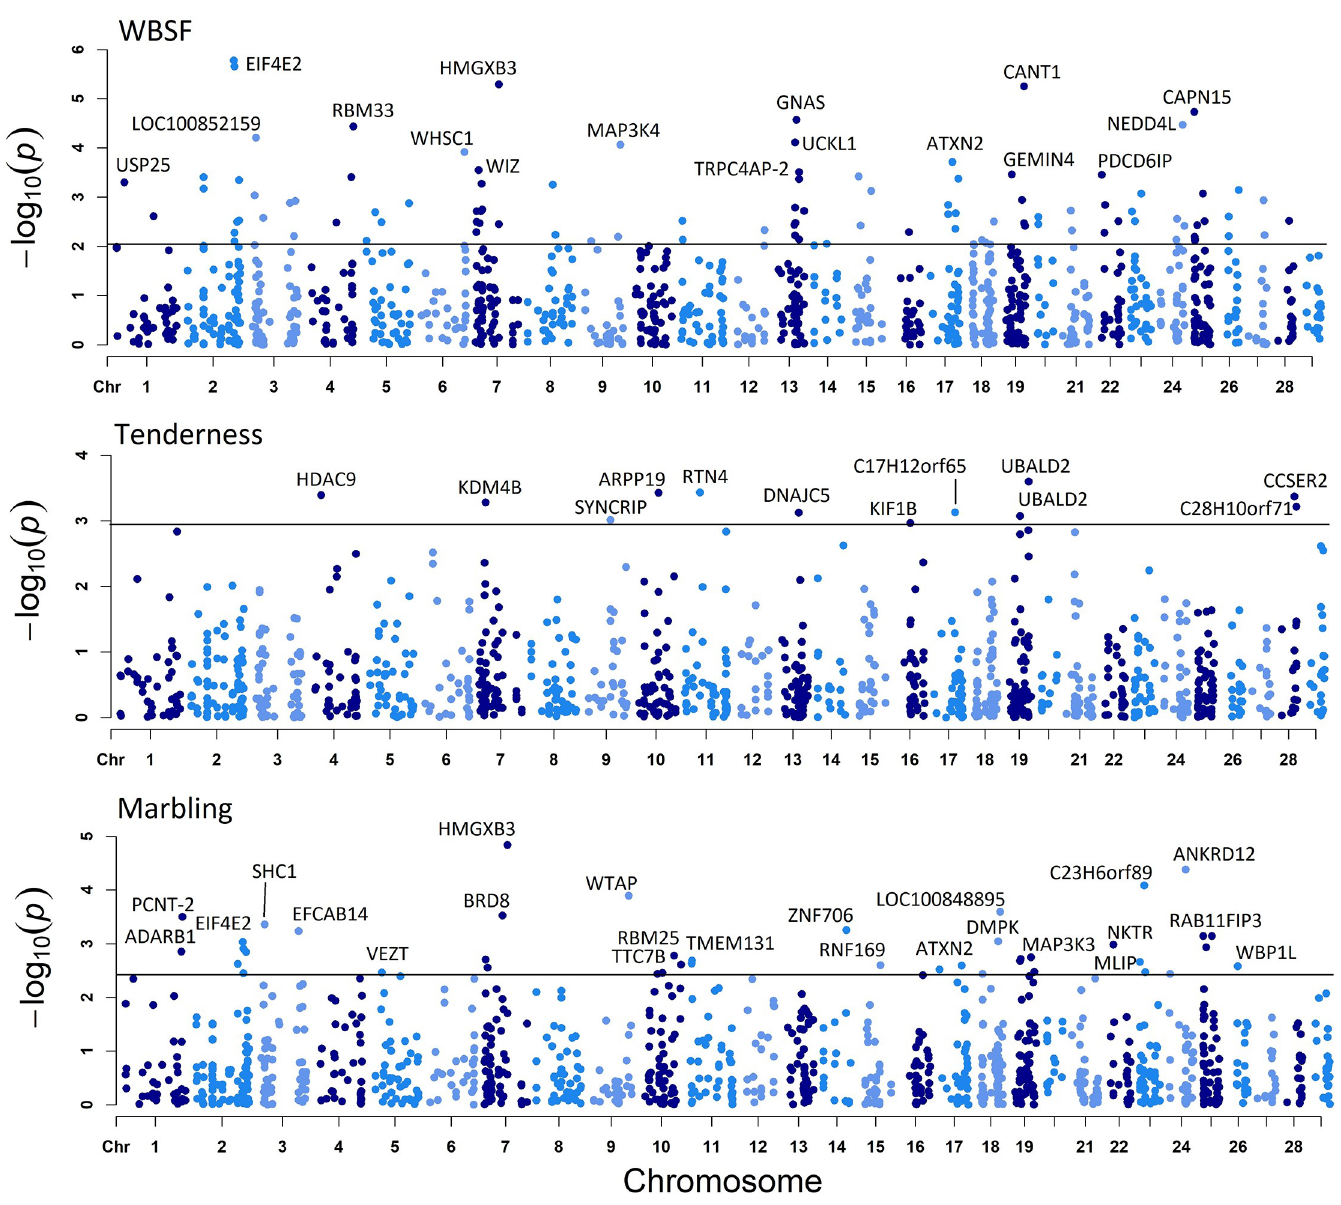
Fig 3. Genes whose isoforms were identified as DE for WBSF (A), tenderness (B) and marbling (C). The x-axis represents gene location across the bovine genome. The black line shows the 0.1 FDR threshold. Different colors represent different chromosomes.